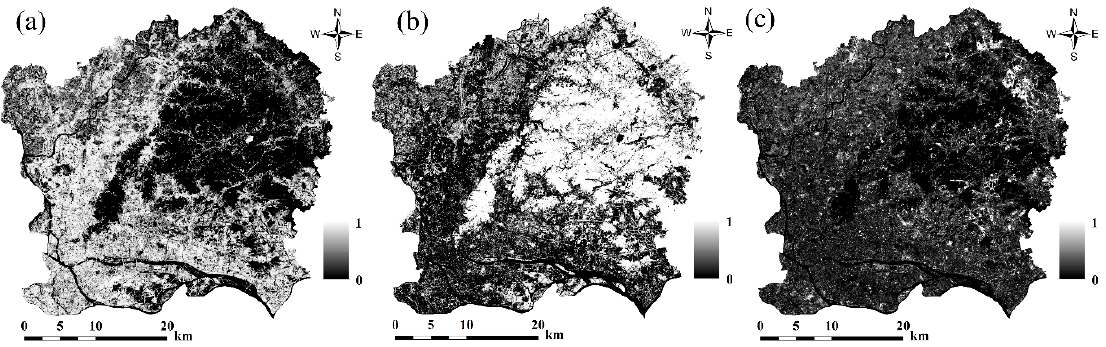
Figure 5. Fraction maps (lighter shades represent increasing representation on a 0–1 scale) extracted